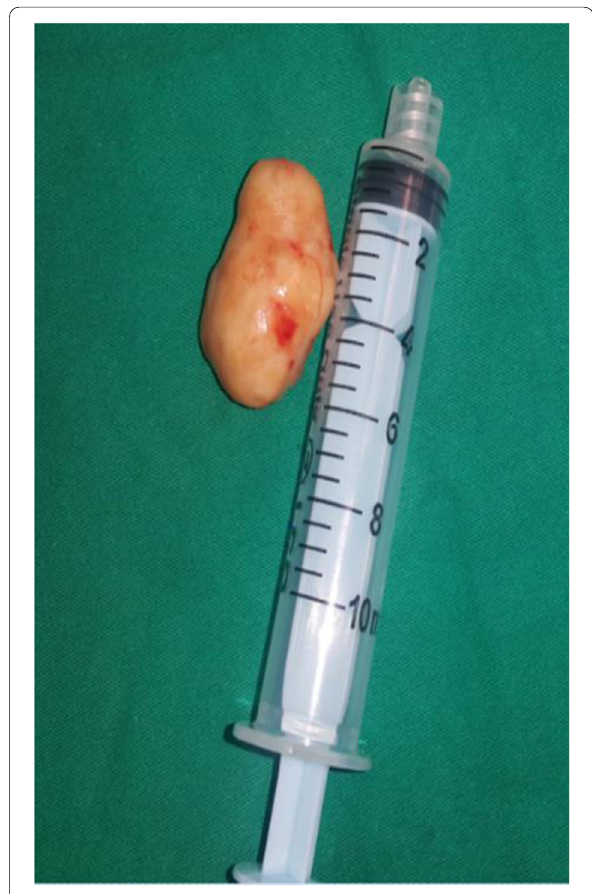
Fig. 4 Excised surgical specimen 6